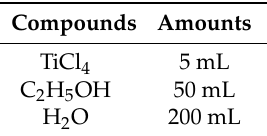
Table 1. Reagents for Synthesis